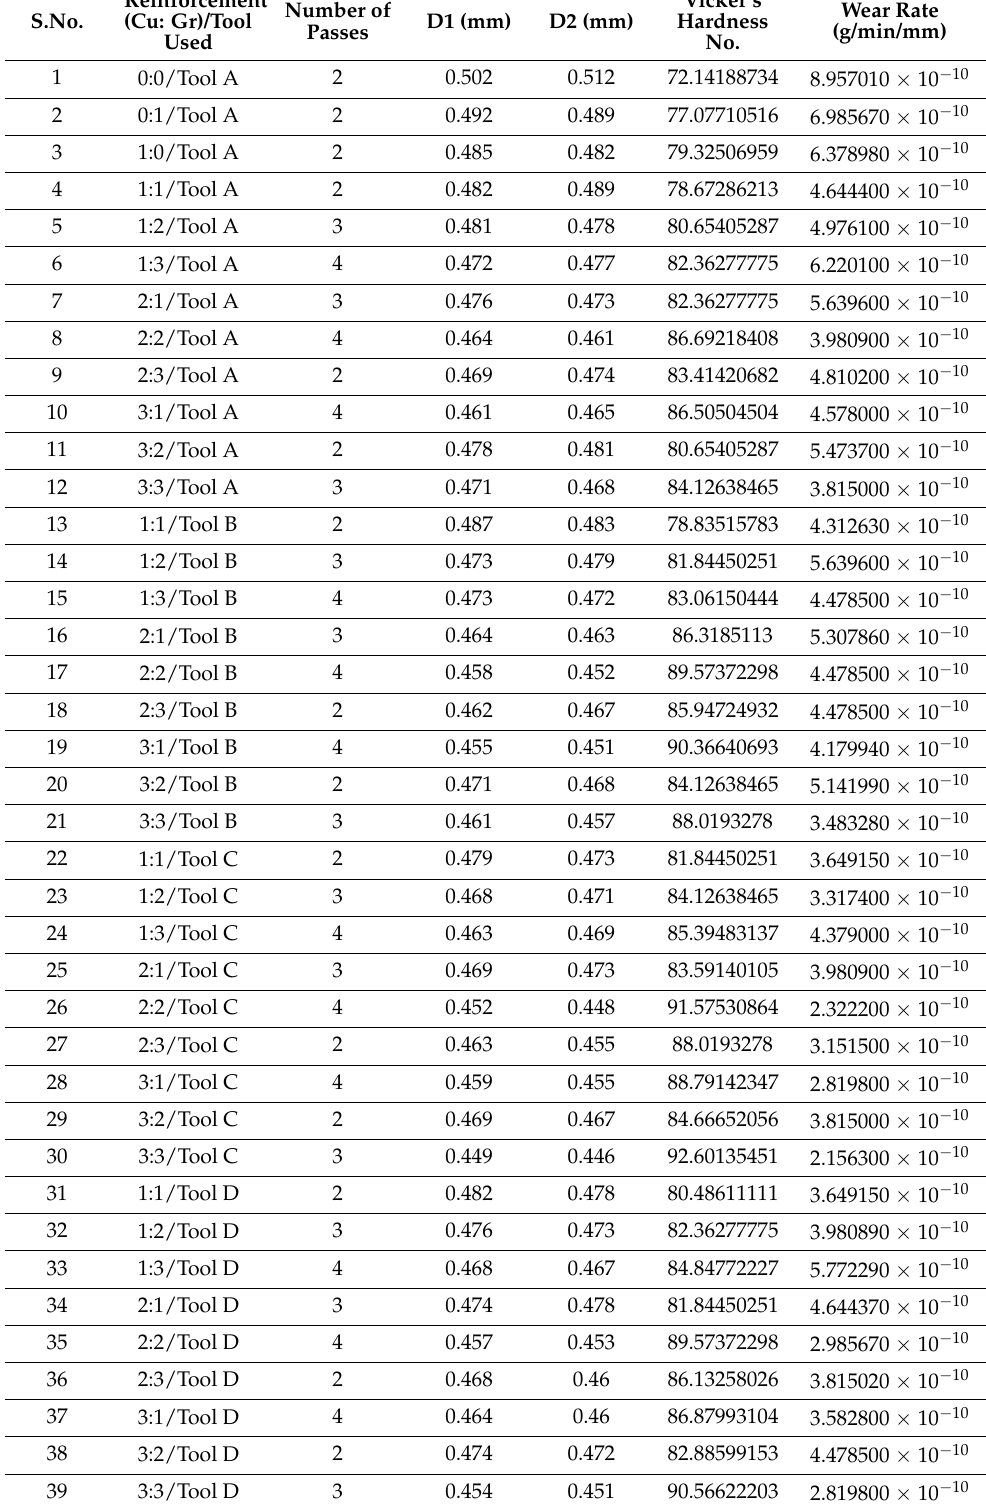
Table 3. Vicker’s hardness number compared to the wear rate for the